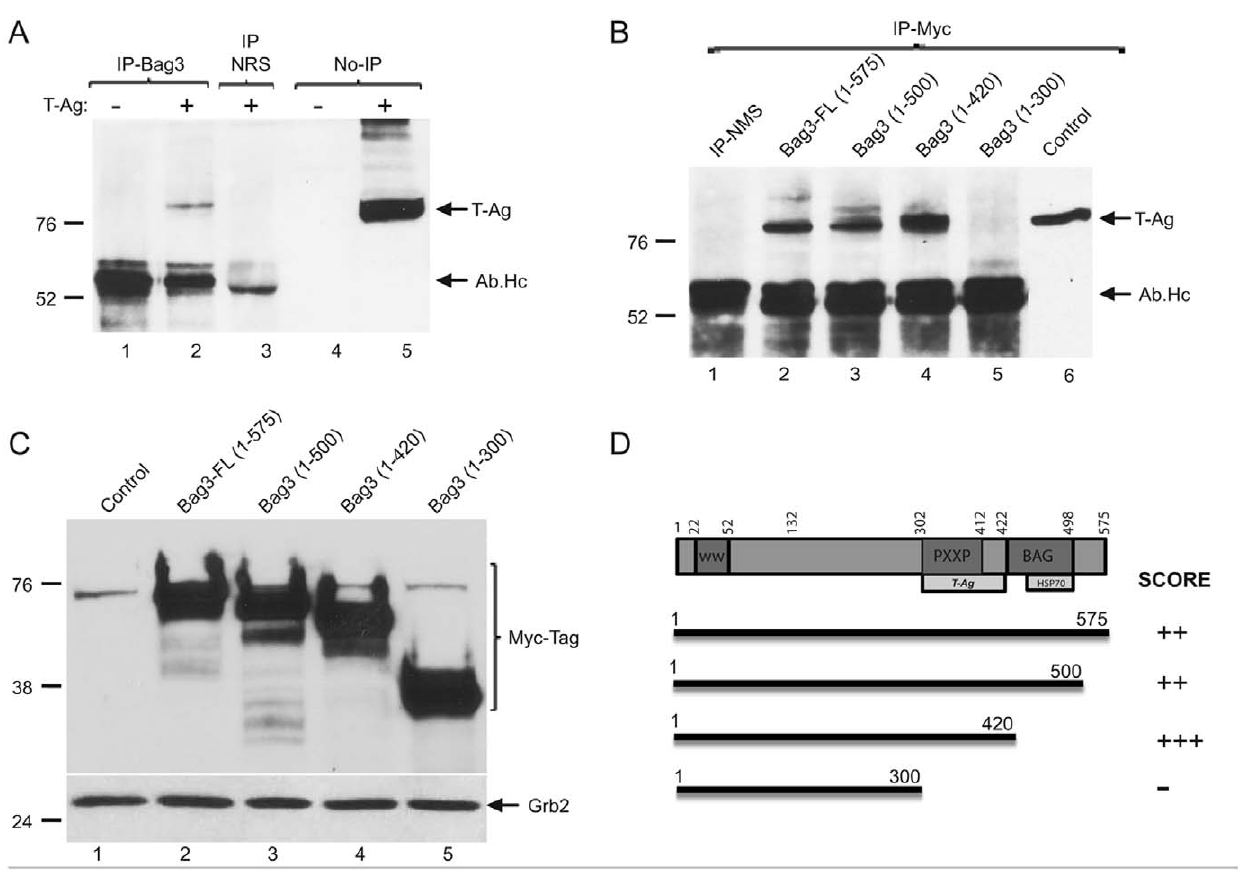
Figure 6. Identification of T-Ag binding site within the Bag3 protein. A. Co-immunoprecipitation of Bag3 with T-Ag. Protein extracts from U- 87MG cells transfected with T-Ag expression plasmid were treated with anti-Bag3 antibody or normal sera (NRS), and the immunocomplexes were analyzed by Western blot using anti-T-Ag antibody. B. Mapping analyses of Bag3 domains that interact with T-Ag. U-87MG cells were transfected with expression plasmids encoding T-Ag along with plasmids expressing full-length Bag3 or its mutant forms. Protein extracts were immunoprecipitated by an anti-myc tag antibody that pulls down the Bag3 fusion proteins. Immune complexes were separated on a SDS-PAGE gel, and Western blot assay was performed to using anti-T-Ag antibody. Antibody heavy chain (Ab.Hc) was also detected by the large T-Ag antibody and is shown as Ab.Hc. C. Western blot analysis for detection of Bag3 full-length protein and its mutant forms using myc-tag antibody as described in Panel B. D. Schematic presentation of the various domains of Bag3 and its binding site to